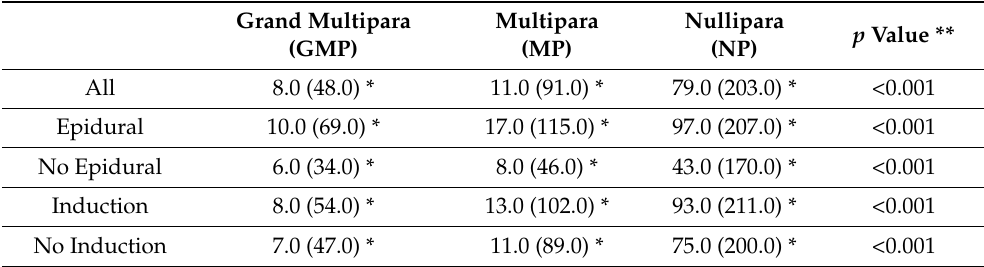
Table 6. Duration of second stage of